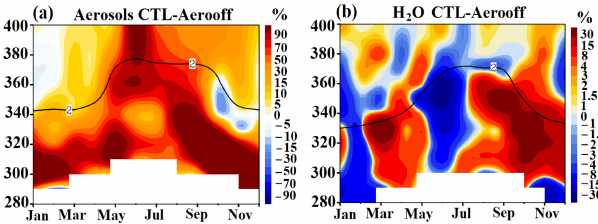
Figure 8. (a) Annual distribution of anomalies of aerosols (CTL- Aerooff) (averaged of BC, OC and sulfate aerosols) (%) averaged over the South Asian region (50–100 ◦ E, 20–40 ◦ N). (b) same as (a) but for water vapor (%) over the northern Indian Ocean–western Pacific (30–140 ◦ E, 20–40 ◦ N). A black line in (a–b) indicates the dynamical